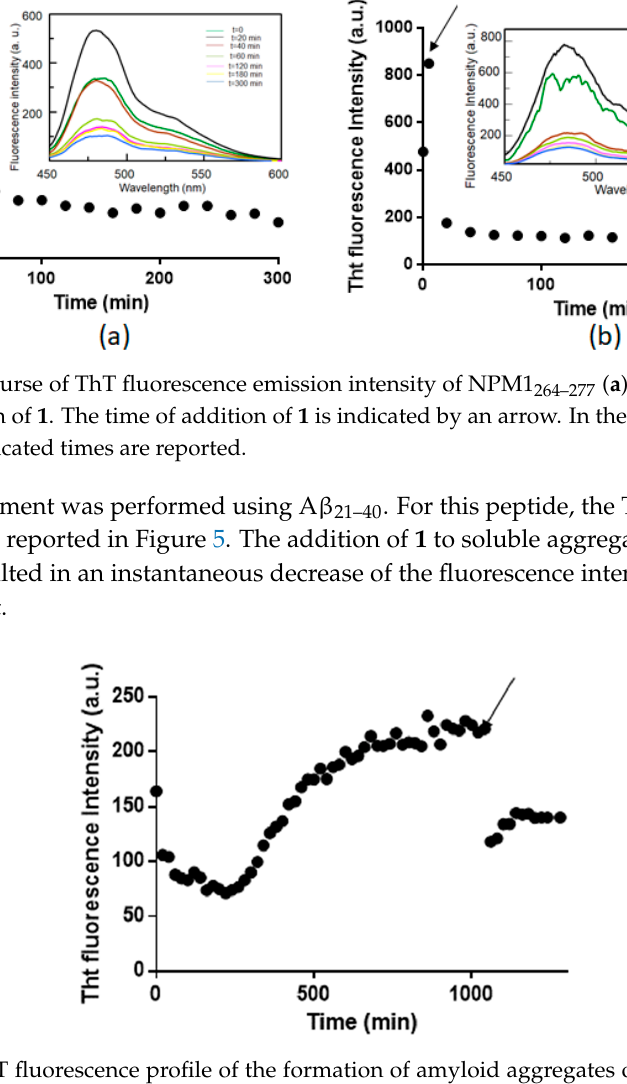
Figure 3. Time course of ThT fluorescence emission intensity of Sup35p 7–13 (black) upon incubation with 1 at 1:1 peptide to Pt compound ratio (blue).